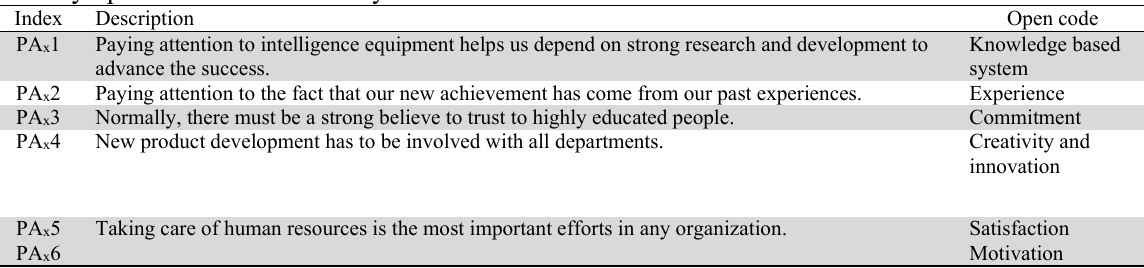
The key open issues for case study